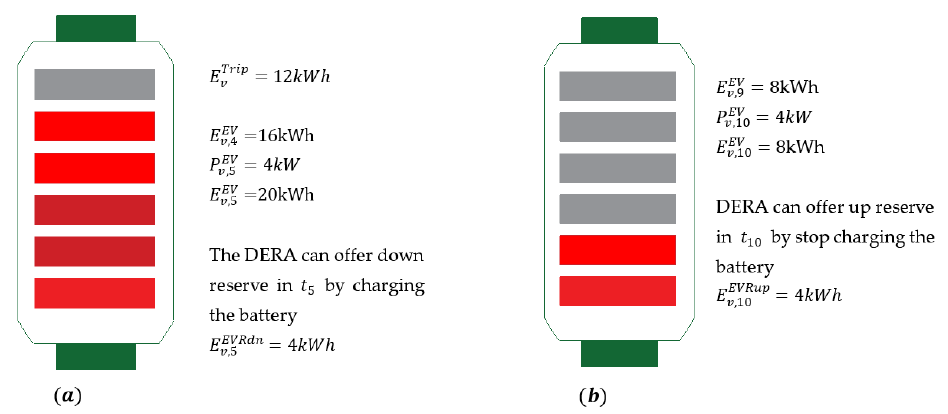
Figure 2. Illustrative example of using the energy of the EV batteries to offer up and down reserve ( a ) Time interval 𝑡 5 , ( b ) Time interval 𝑡 10 .